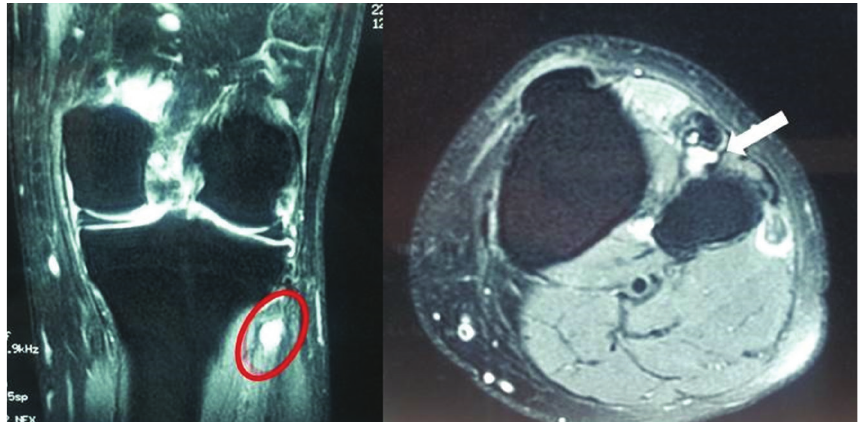
Figure 1: Left knee MRI demonstrated a lobulated, multilocular, and well-demarcated cystic-appearing mass medial to the fibular head (ganglion).